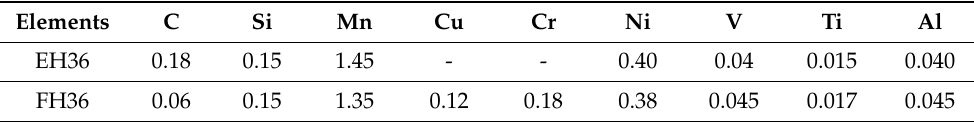
Table 1. Chemical composition of the experimental steels (wt.%).